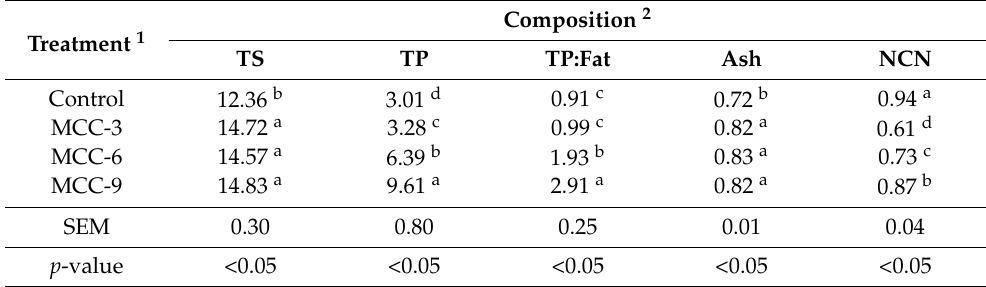
Table 2. Mean (n = 3) composition values (% by weight) of whole milk and micellar casein concentrate (MCC) solutions utilized in the manufacture of Feta-type